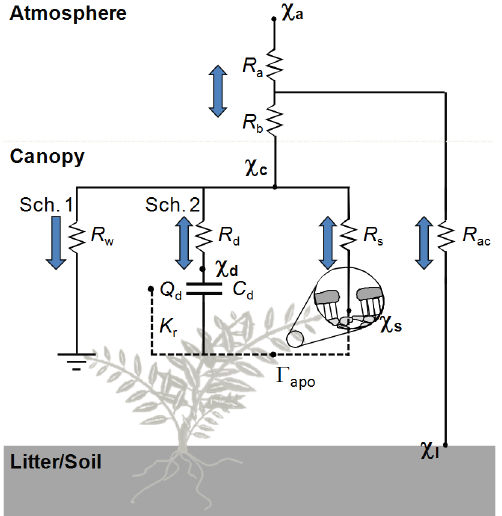
Figure 4. A resistance analogue of NH 3 exchange including cu- ticular, stomatal, and pathways to soil (Sutton et al., 2013b). Two methods for cuticular exchange schemes are shown: (1) steady-state uptake according to a varying cuticular resistance ( R w ) ; (2) dy- namic exchange with a reservoir of NH + using a varying capaci- 4 tance ( C d ) and charge ( Q d ) . Within-canopy transfer ( R ac ) , cutic- ular adsorption–desorption ( R d ) and stomatal exchange ( R s ) . Also shown are the air concentration ( χ a ) , cuticular concentration ( χ d ) , stomatal compensation point ( χ s ) , litter–soil surface concentration ( χ l ) and the canopy compensation point ( χ c )